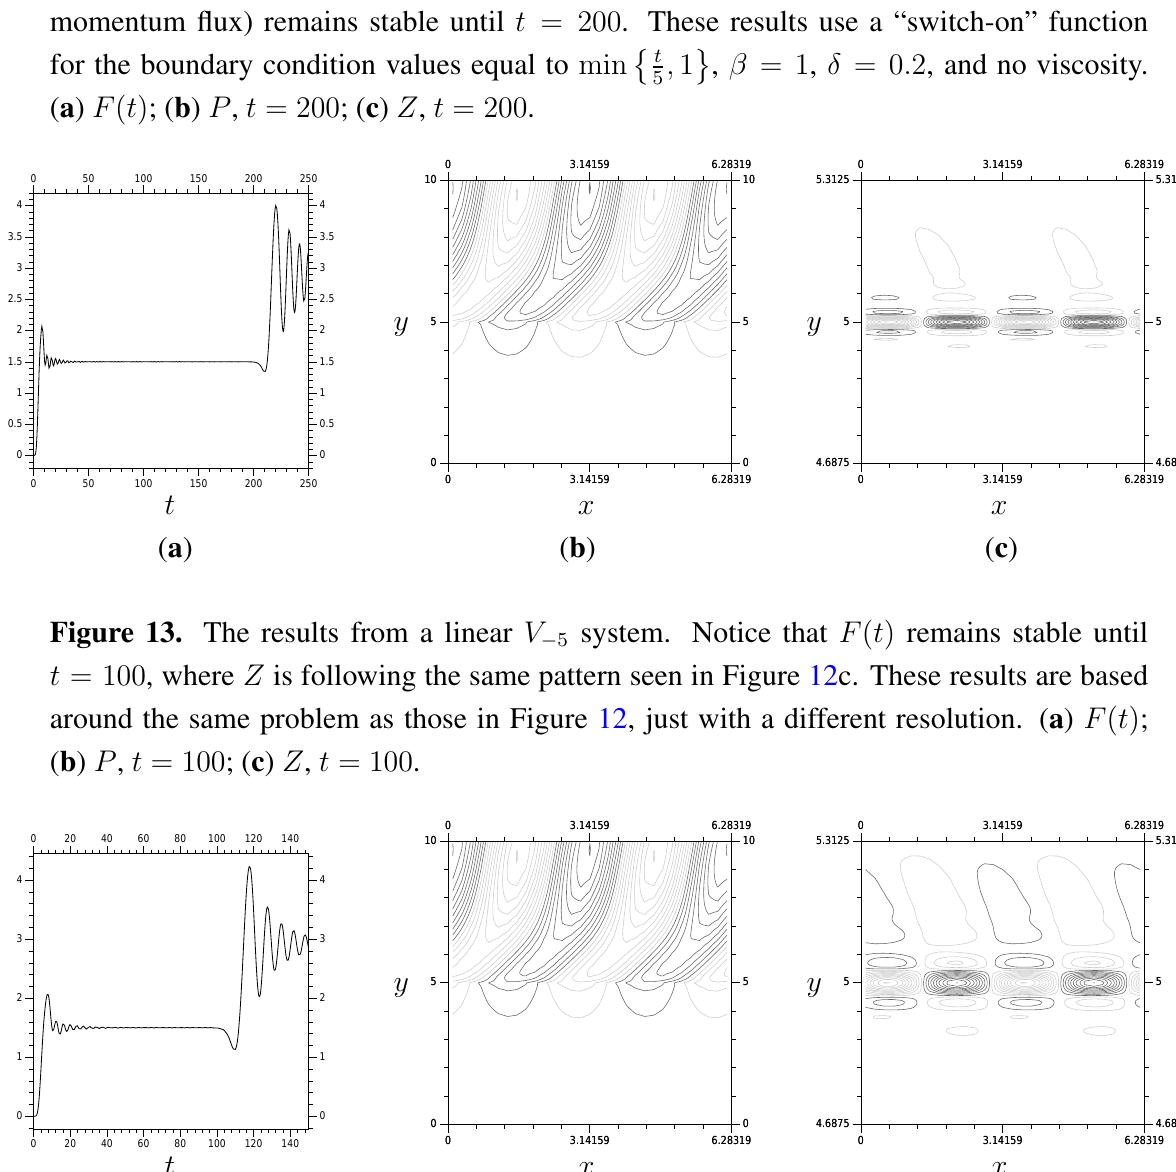
Figure 12. The results from a linear V − momentum flux) remains stable until t = 200 . These results use a “switch-on” function for the boundary condition values equal to min